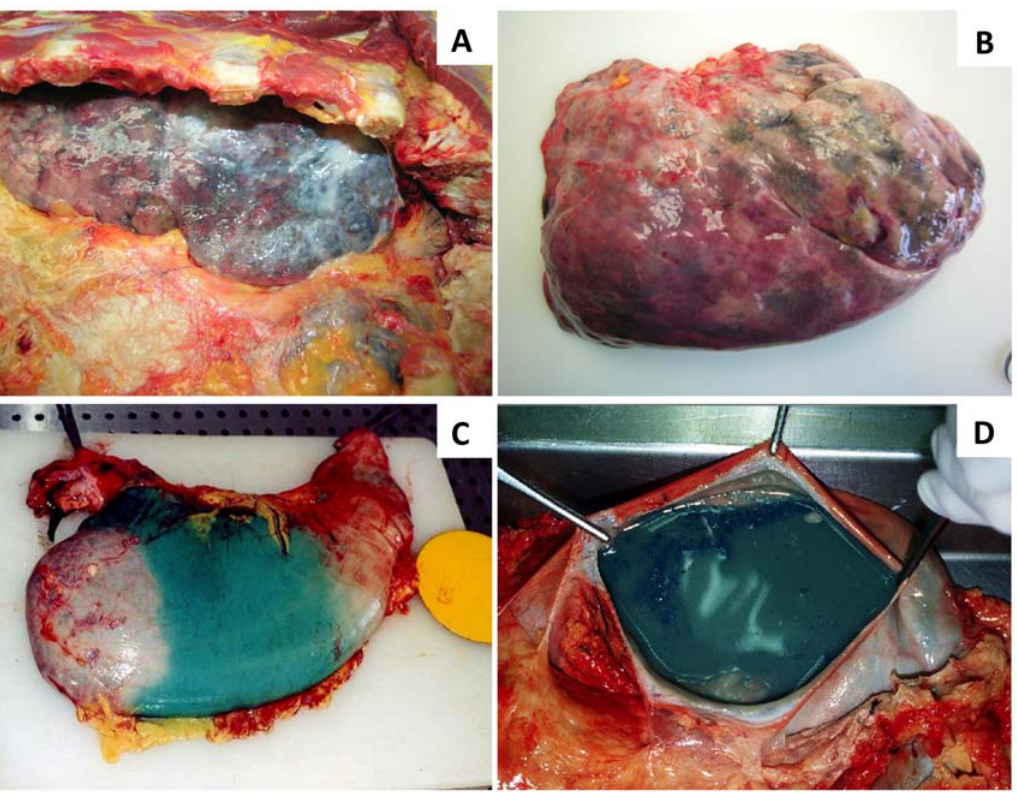
Figure 1. Autoptic macroscopic photodocumentation. A: lung fibrosis of case 5; B: lung edema of case 4; C and D: greenish blue colour appearance of gastrointestinal organs of case